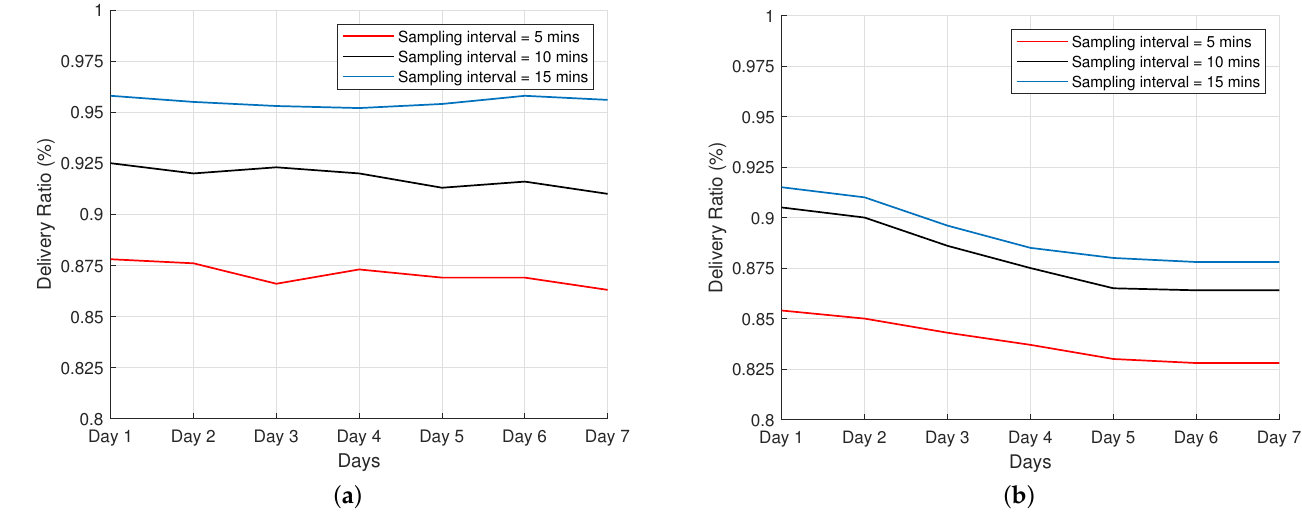
Figure 9. Average delivery ratio at the network server. ( a ) ADR disabled; ( b ) ADR enabled.